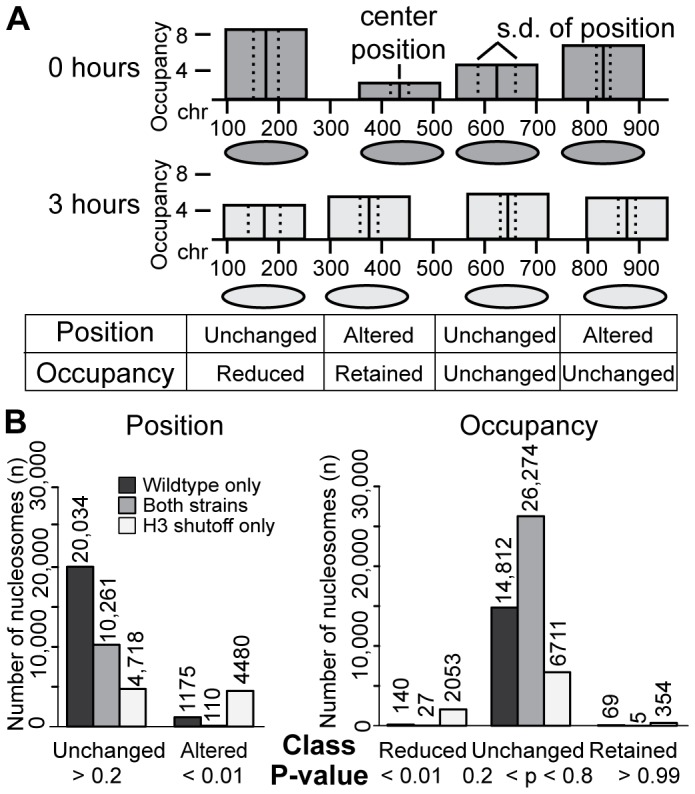
A subset of nucleosomes demonstrate behaviors specific to H3 depletion.(A) Schematic representation of the nucleosome classification method. Nucleosomes were classified based on changes in center positions and changes in read center counts between 0 hours and 3 hours (Materials and Methods). (B) Classification of nucleosomes. The number of nucleosomes in each classification that occur in only the wildtype strain 3 hours after the shift to Galactose (black); only the H3 shutoff strain (white); and those classified identically in both strains (gray) is shown. Only the H3 shutoff-specific nucleosomes (white) were used in subsequent analyses. The total number of nucleosomes that could be classified in each category are as follows: wildtype, 43,508; H3 shutoff, 38,955; classified in both, 28,717.